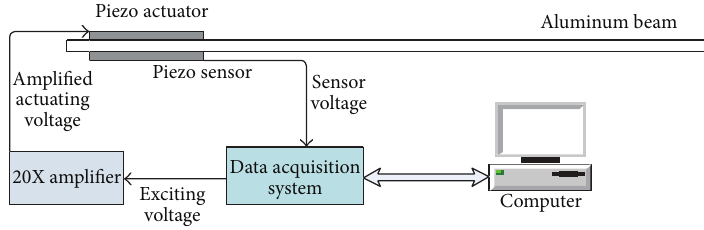
Figure 2: Schematic diagram of the Experiment.